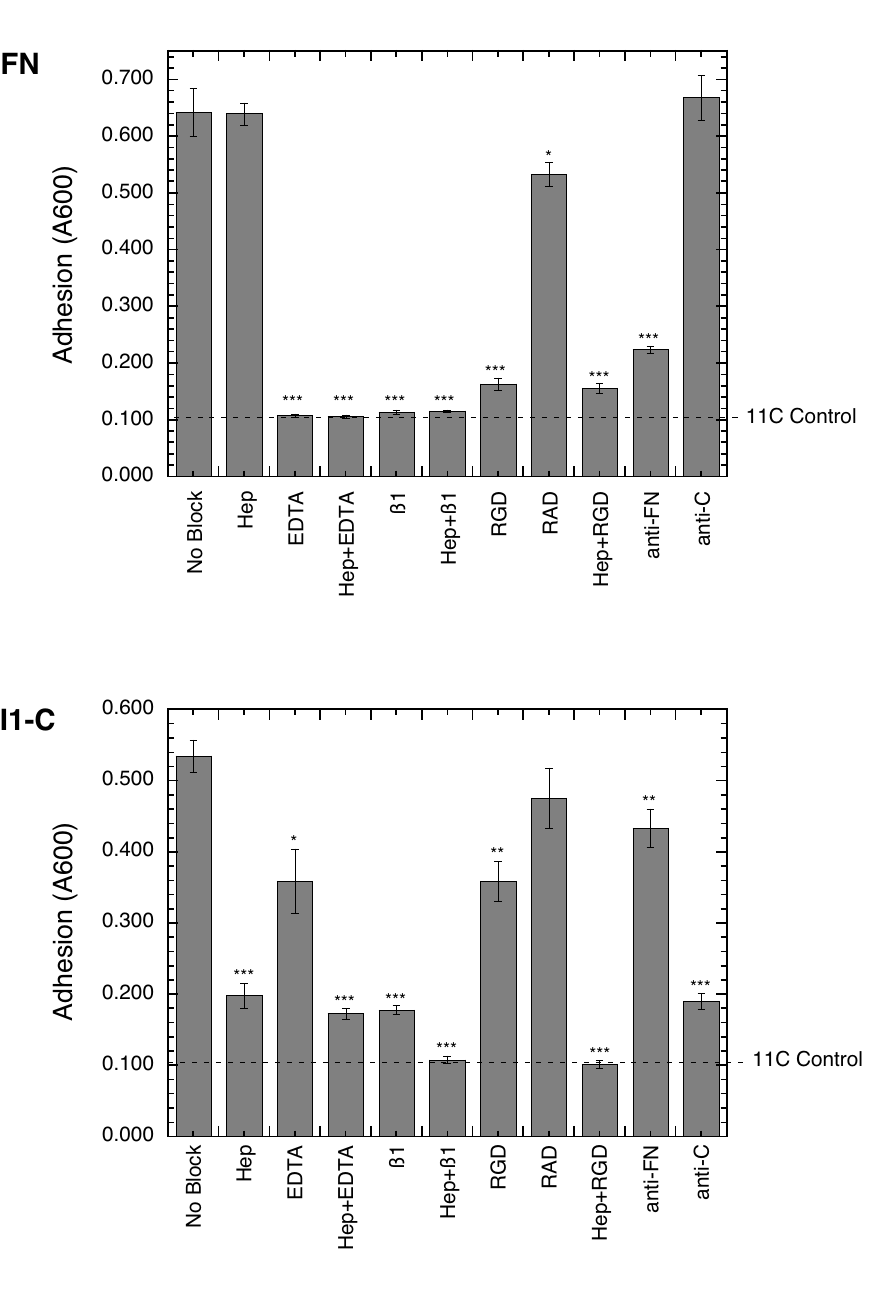
Figure 3 Blocking of cell attachment to III1-C RASMCs were seeded onto wells coated with either 20 µ g/ml FN (top panel), or 25 µ M III1-C (bottom panel) in the absence or presence of various inhibitors. The inhibitors were 100 µ g/ml heparin (Hep), 10 mM EDTA (EDTA), 50 µ g/ml anti- β 1 blocking mAb Ha2/5 (pi), 0.5 mg/ml GRGDSP peptide (RGD), 0.5 mg/ml GRADSP pep- tide (RAD), 100 µ g/ml anti-FN polyclonal antibody (anti-FN), and 60 µ g/ml anti-IIIl-C polyclonal antibody (anti-C). After 30 min at 37 ° C the cells were fixed, stained with crystal violet and the amount of cell attachment was measured. The dashed line indi- cates the amount of signal seen on the negative control protein III 11-C, and represents the background A600 reading in these experiments. Statistical analysis was done by Student's T-test (2-tailed); * p < .05, ** p < .005, *** p < .0005. Each sample was done in quadruplicate and the experiment was performed three times with similar results each